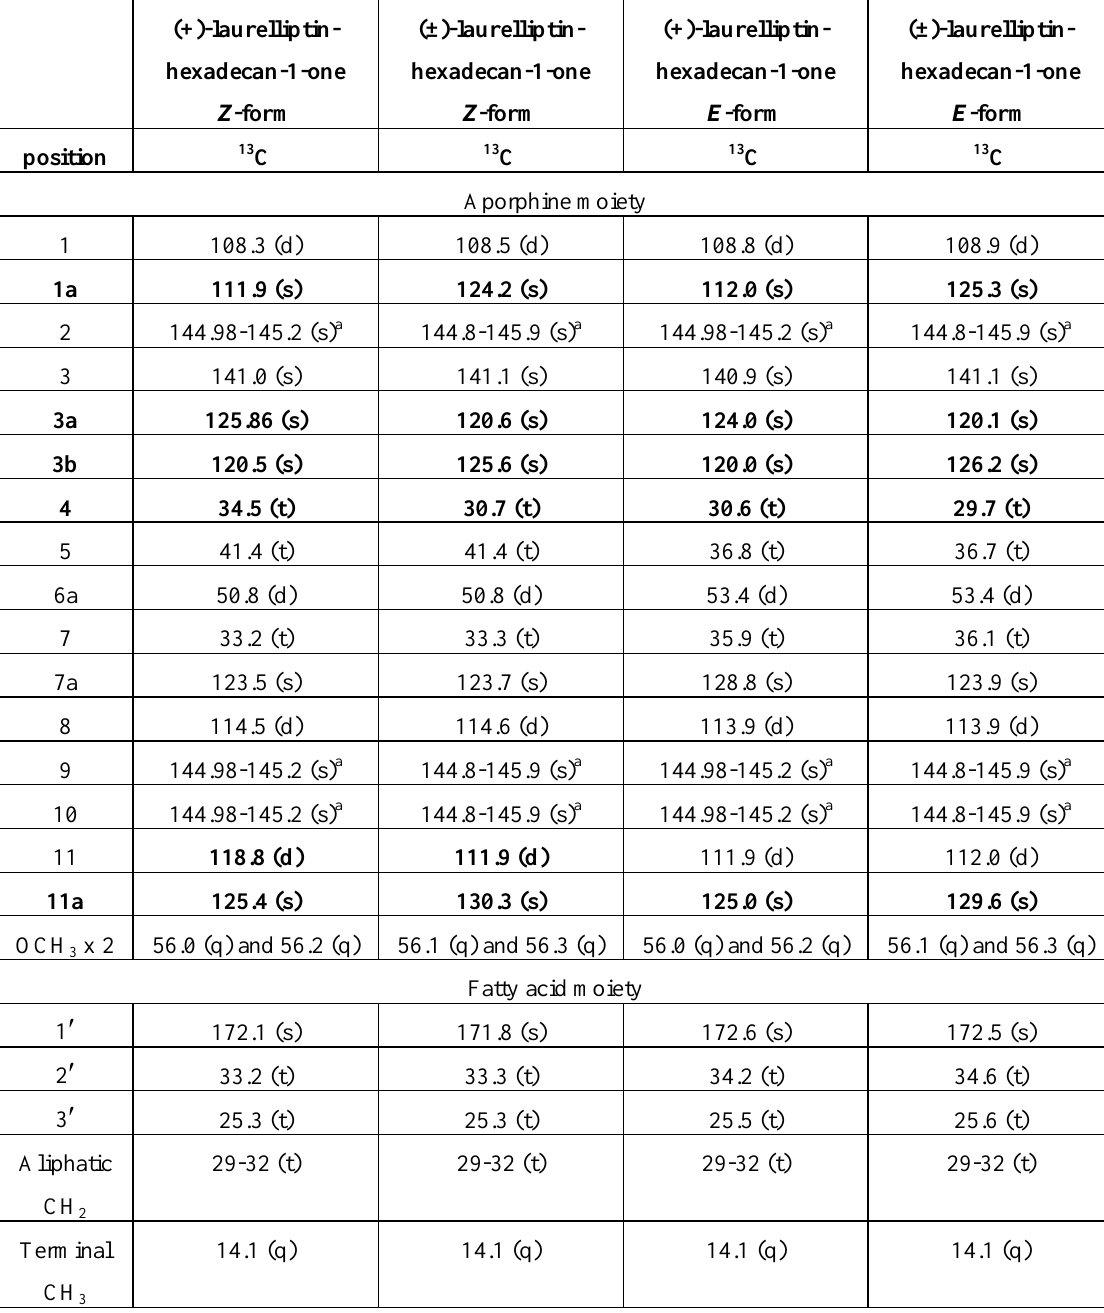
Table 2 . Comparison of 13 C-NMR spectral data between (+)-laurelliptinhexadecan-1-one (150 MHz, CDCl ) and (±)-laurelliptinhexadecan-1-one (75 MHz, CDCl 3